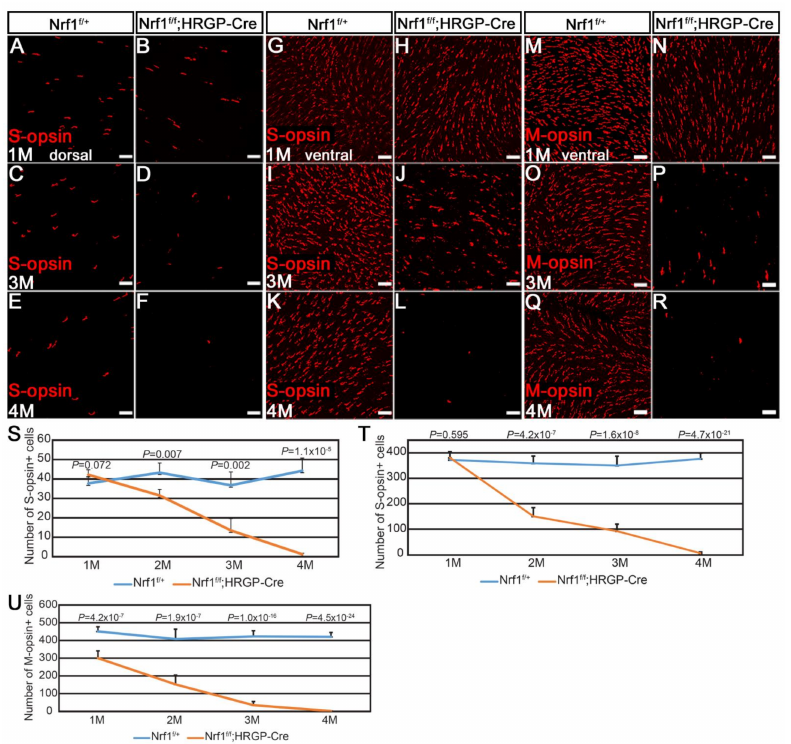
Figure 2. Nrf1 conditional knockout by HRGP-Cre causes degeneration of S- and M-opsin. ( A – R ) Immunostaining of Nrf1 f/+ ( A , C , E , G , I , K , M , O , Q ) and Nrf1 f/f ;HRGP-Cre ( B , D , F , H , J , L , N , P , R ) retinal flat-mounts with anti-B opsin ( A – L ) and anti-RG opsin ( M – R ) at 1 month, 3 months, and 4 months old. ( S , T ) Number of S-opsin + cells at dorsal area ( S ) and ventral area ( T ) of Nrf1 f/+ and Nrf1 f/f ;HRGP-Cre retinal flatmount. ( U ) Number of M-opsin + cells of Nrf1 f/+ and Nrf1 f/f ;HRGP-Cre retinal flatmount. Scale bars: 20 µ